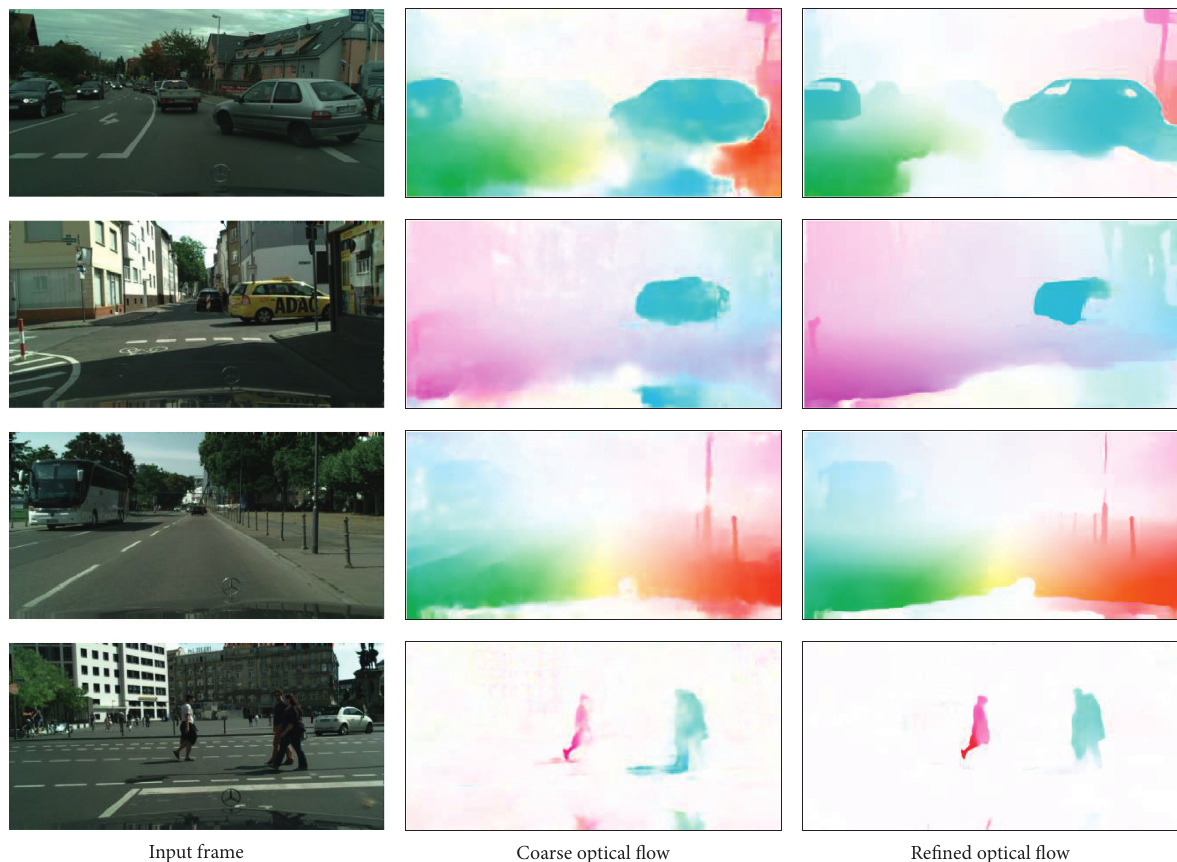
Figure 3: Visual comparison on the Cityscapes dataset for the original optical flow. The first column denotes the input frame. The middle column denotes the coarse optical flow produced by the optical flow network. The last column denotes the refined optical flow optimized by the flow refinement module. The refined optical flow has sharper motion boundaries than the original optical